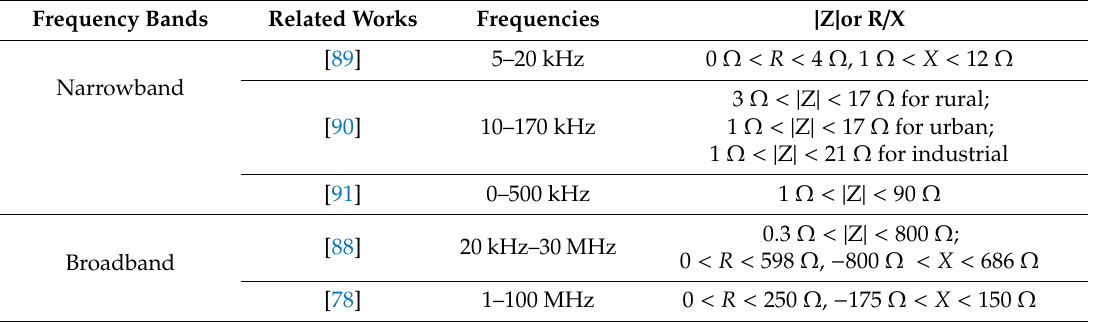
Table 2. The overview of the access impedance measurements for narrowband and broadband